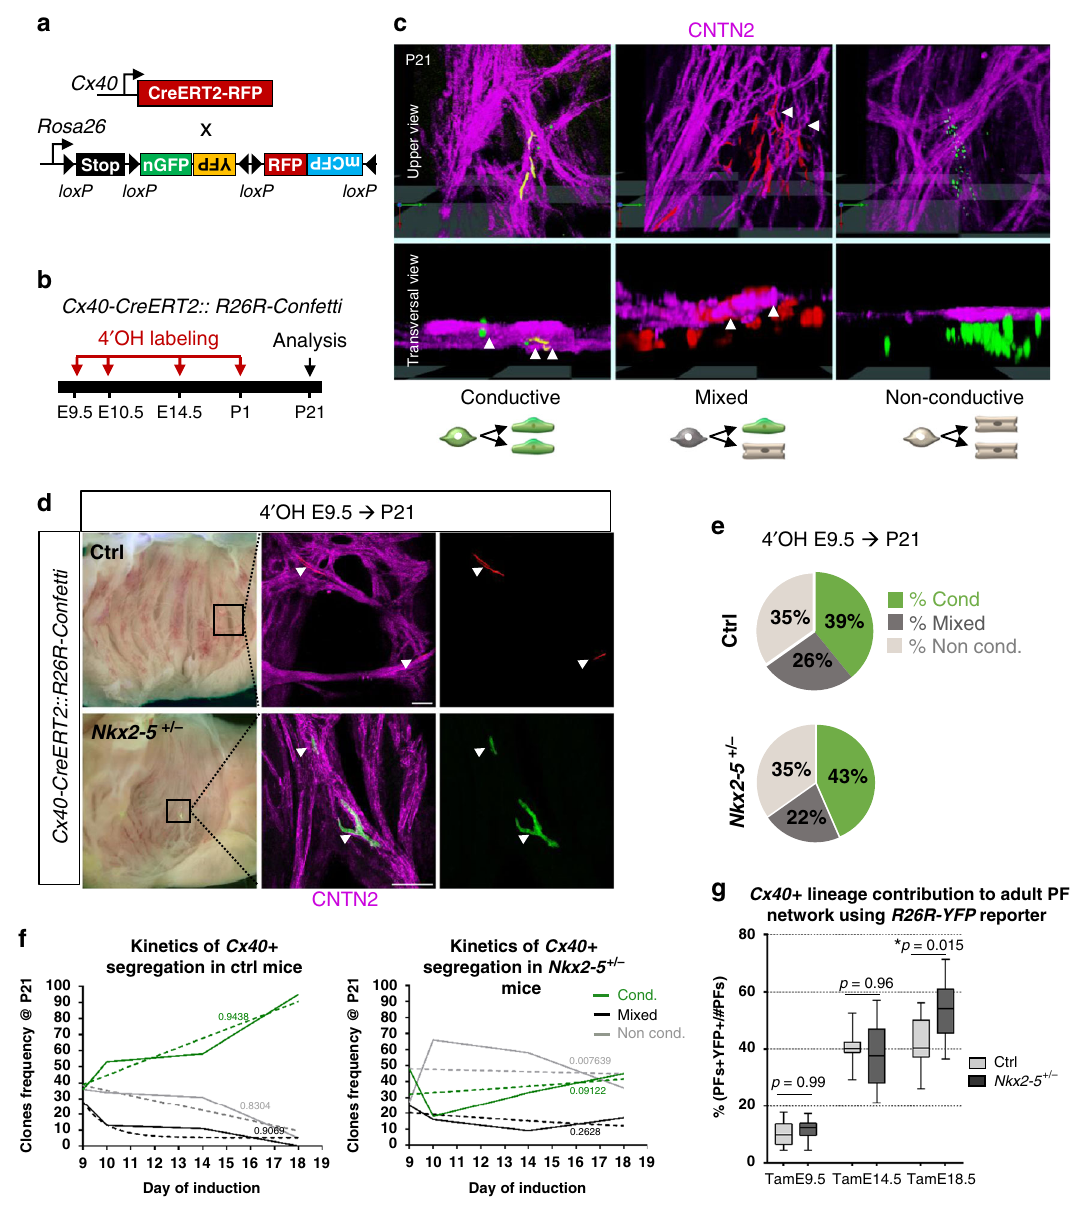
Fig. 2 Temporal clonal analysis of single Cx40 + trabecular cells during embryonic stages. a Scheme of the strategy used for clonal genetic tracing of Cx40 + cells. R26R-Confetti multicolor reporter mice are crossed with tamoxifen-inducible Cx40-CreERT2 mice. Four alternative recombination (nGFP, YFP, RFP, and mCFP) are possible. b Low doses of 4-hydroxytamoxifen (4 ’ OH-Tam) are injected at different time points of development to induce low-frequency recombination. Analyses of independent unicolor clones are made at P21. c 3D reconstructions of clones imaged at the subendocardial surface of the left ventricle. Whole-mount immunostaining for Contactin-2 (CNTN2) is used to distinguish conductive, mixed and non-conductive clones. Arrowheads indicate cells positive for CNTN2. Schemes illustrate the lineage origin of each clone. d Confocal images of whole-mount CNTN2-immunostaining of 3-week-old Cx40- CreERT2::R26R-Confetti opened-left ventricle induced at E9.5 from control (Ctrl) and Nkx2-5 + / − hearts. Conductive clones are indicated by arrowheads. Scale bars = 100 µ m. e Percentages of conductive, mixed and non conductive clones induced at E9.5 were quanti fi ed in P21 control (Ctrl) and Nkx2-5 + / − left ventricles. f Clone frequency evolution upon time-course inductions quanti fi ed in P21 control ( Ctrl) and Nkx2-5 + / − mice. The progressive decrease of mixed clones over time illustrates the kinetics of Cx40 + trabecular progenitors segregation. Dashed lines: non-linear regression curves with R square values. g Graphs of the percentage of labeled adult PFs according to Cx40 + lineage traced by Tam injections at E9.5, E14.5, or E18.5. Box plots show the median, the 25th and 75th percentile, and the whiskers denote the minimum and maximum values, respectively. Quanti fi cations were performed on Cx40-CreERT2::R26R-YFP control (ctrl) or Nkx2-5 + / − heart transverse sections. Mean of 3 sections/heart (Tam E14.5; Tam E18.5); 4 sections/heart (TamE9.5); ( n = 3 TamE9.5 Ctrl, TamE18.5 Ctrl and Nkx2-5 + / − ; n = 4 TamE9.5 Nkx2-5 + / − , TamE14.5 Ctrl and Nkx2-5 + / − ). P values are derived ordinary one-way ANOVA test (Tukey test), * P